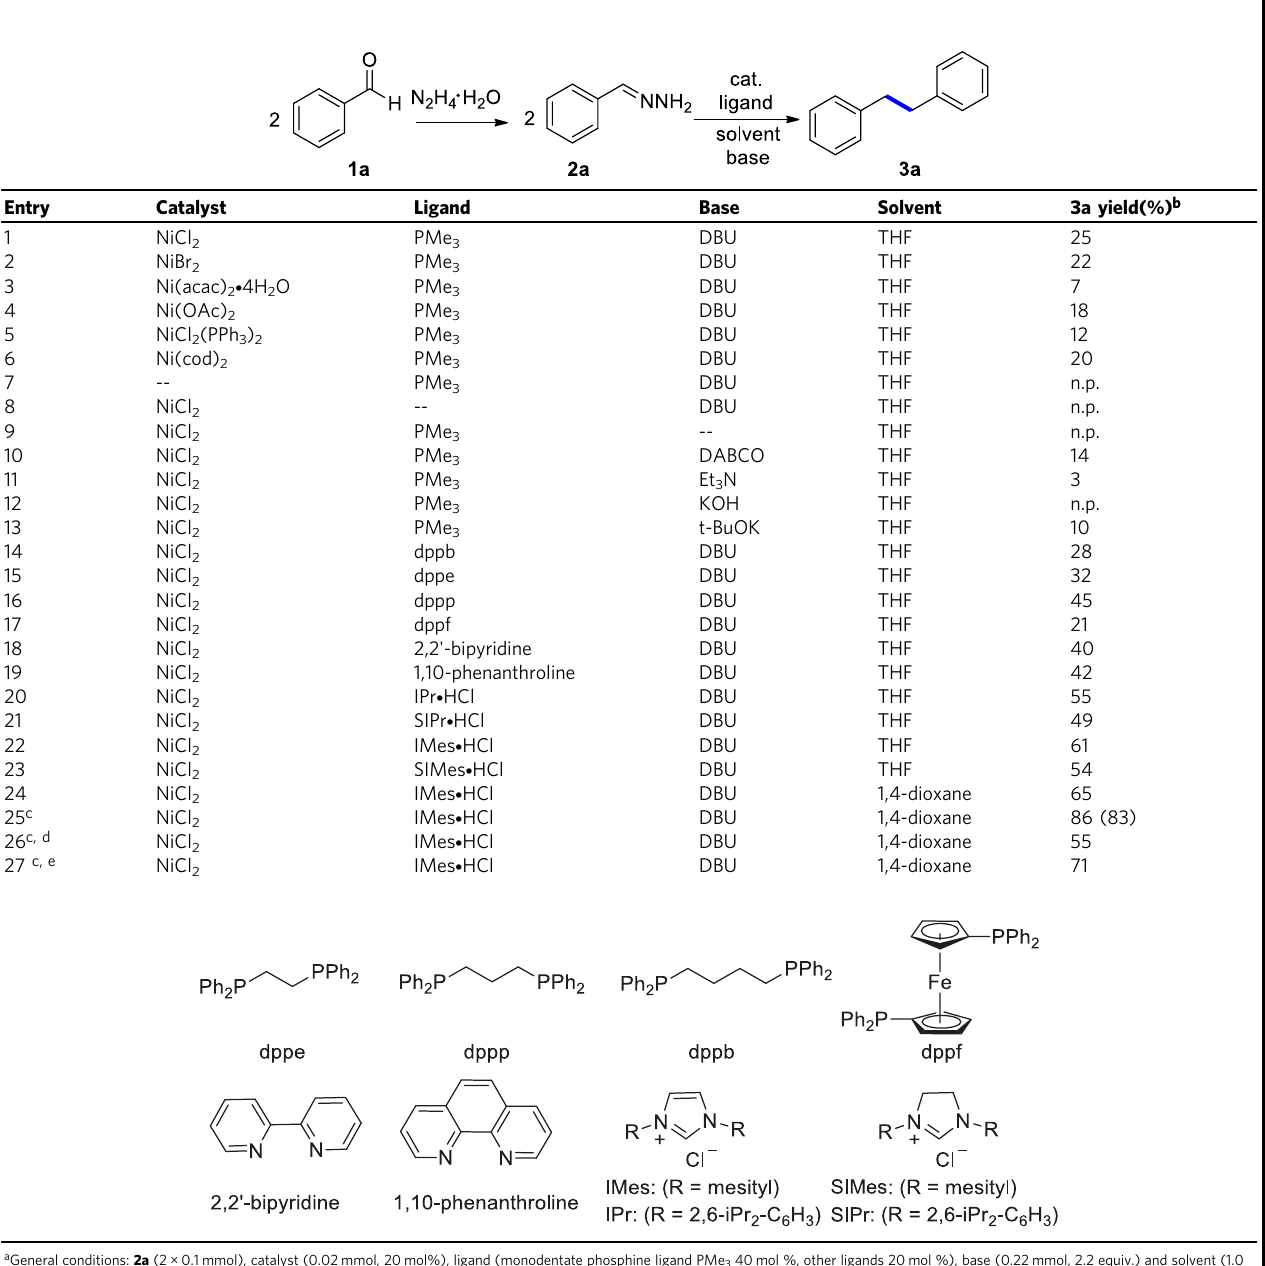
Table 1 Optimization of the reaction conditions a